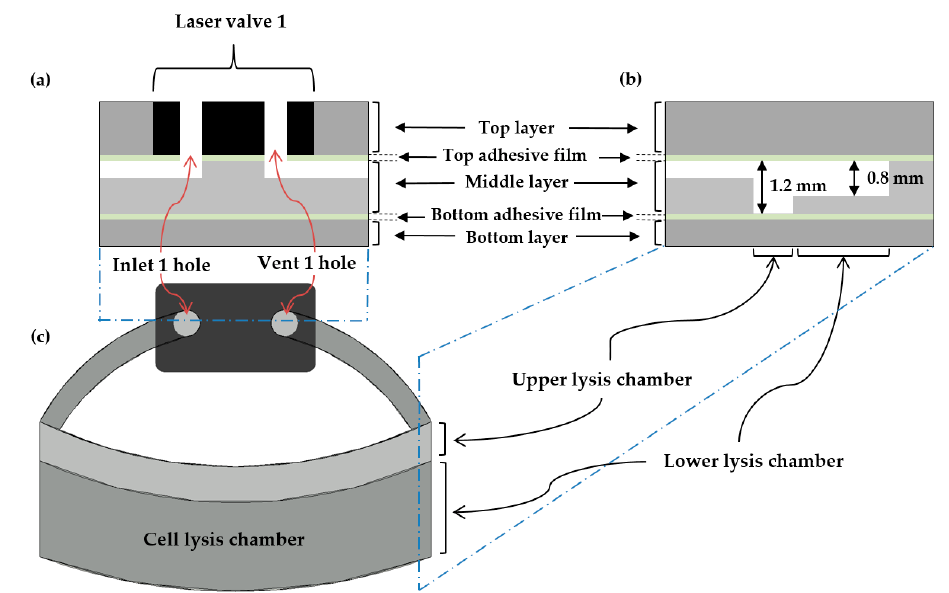
Figure 4. Schematic of laser valve 1 and the cell-lysis chamber. ( a ) Front view of laser valve 1, showing that the inlet and vent have an all-in-one form; thus, they can be simultaneously closed with one shot of the laser beam. ( b ) Right-side view of the cell-lysis chamber, showing the different heights of the internal structure, which consists of the upper (1.2 mm thick) and lower (0.8 mm thick) lysis chambers. This height differential allows the capillary-induced force to block the liquid from flowing out toward the channel. ( c ) Top view of laser valve 1 and the cell-lysis chamber.